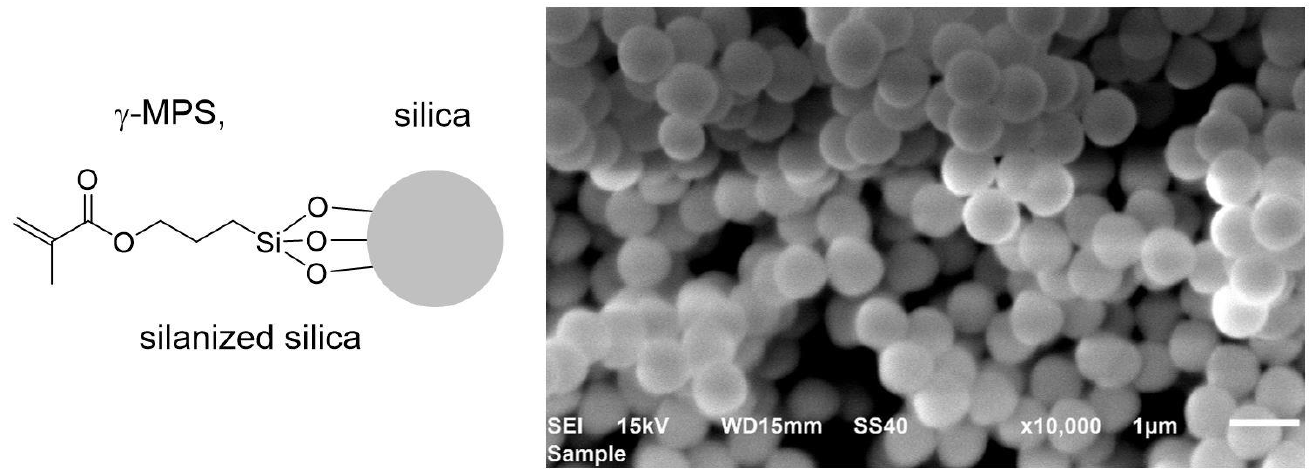
Figure 3. Scanning electron microscope (SEM) image of the synthesized silanized silica. The image scale bar is 1 µm.